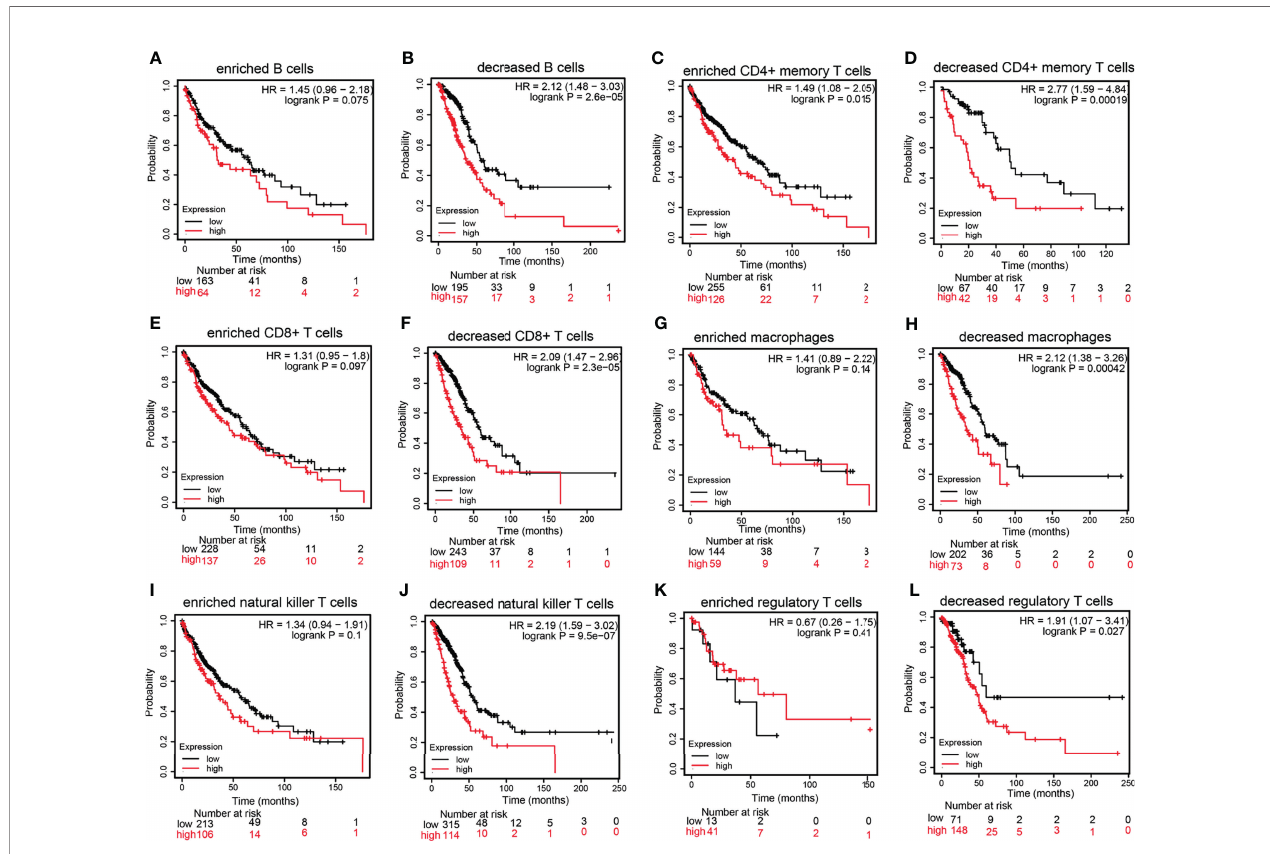
FIGURE 7 | Prognostic potential of the expression of hyaluronan-mediated motility receptor ( HMMR ) in different tumors based on immune cells. (A – L) Relationship between HMMR expression and overall survival (OS) based on the immune cell subgroups examined using the Kaplan – Meier (KM)